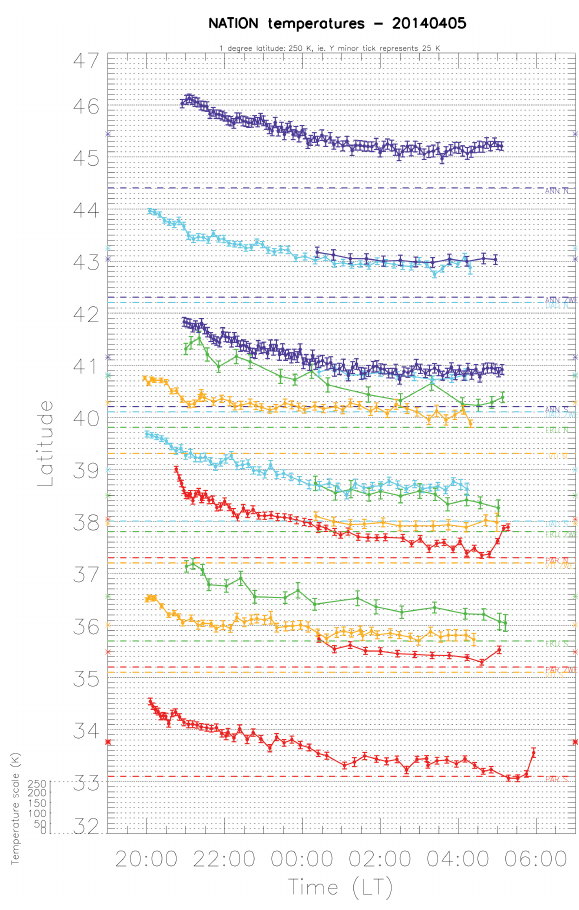
Figure 8. NATION latitudinal temperature distribution graph for 5 April 2014, illustrating the lack of the double or single MTM structure. Each color represents the FPI temperature results of a NA- TION station with a set of three temperature lines (North, zonal, and South directions). From bottom to top, the line colors of red, orange, green, blue, and purple represent results for the PAR, VTI, EKU, UAO, and ANN NATION sites, respectively. The North, zonal, and South measurements are shifted to their respective latitudes, and the horizontal dashed baseline represents 800K for that particular mea- surement. The magnitude of one degree latitude corresponds to a 250K difference. The asterisks on the left and right vertical axes represent the temperature averages for each latitude set of measure-